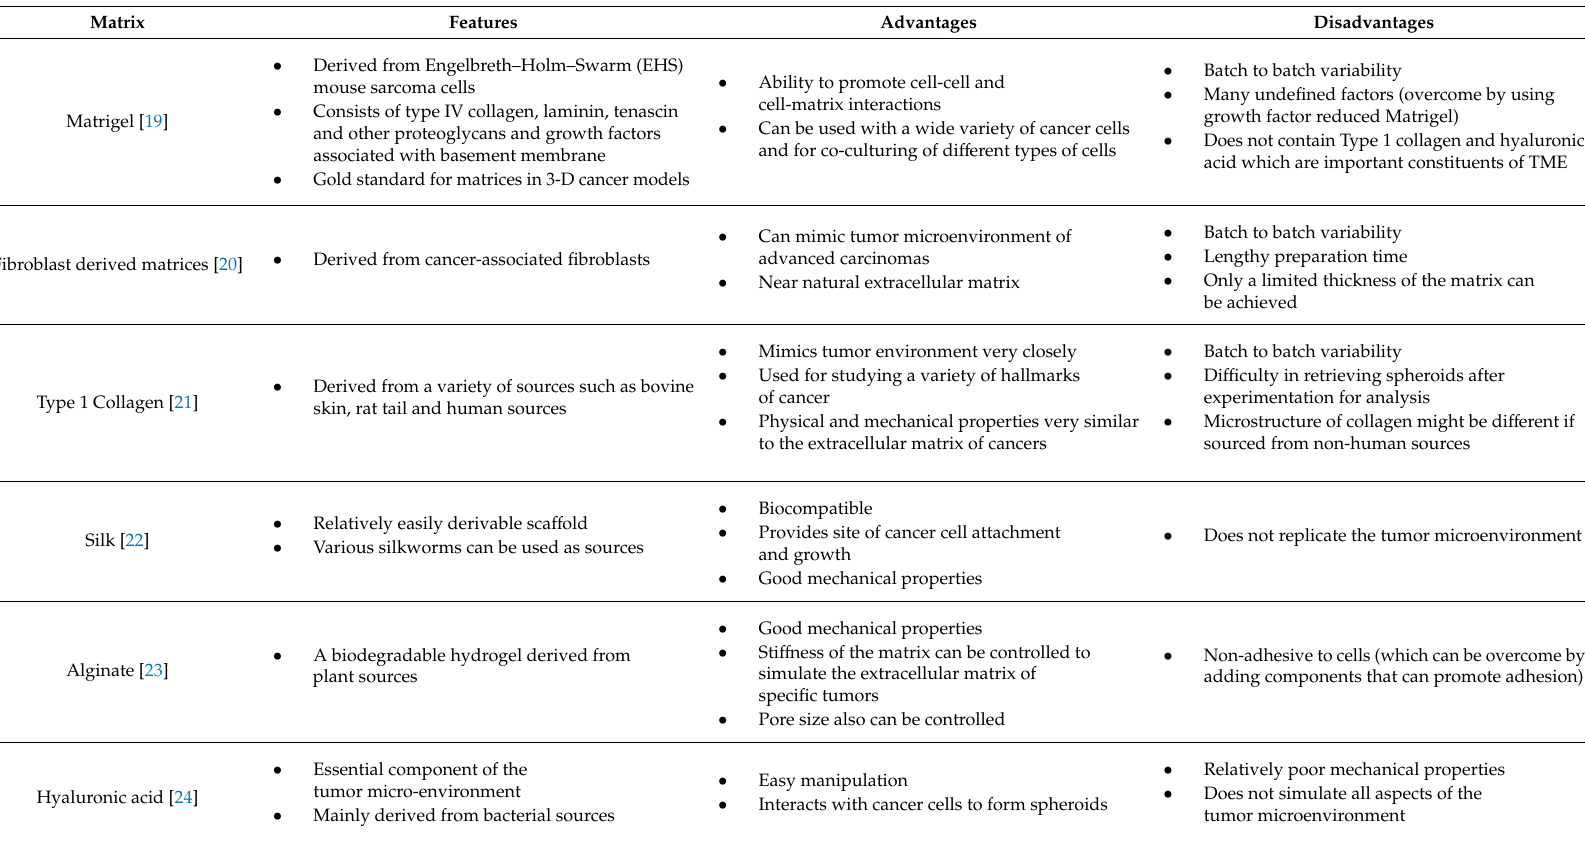
Table 1. Natural matrices used in three-dimensional 3-D in vitro cancer